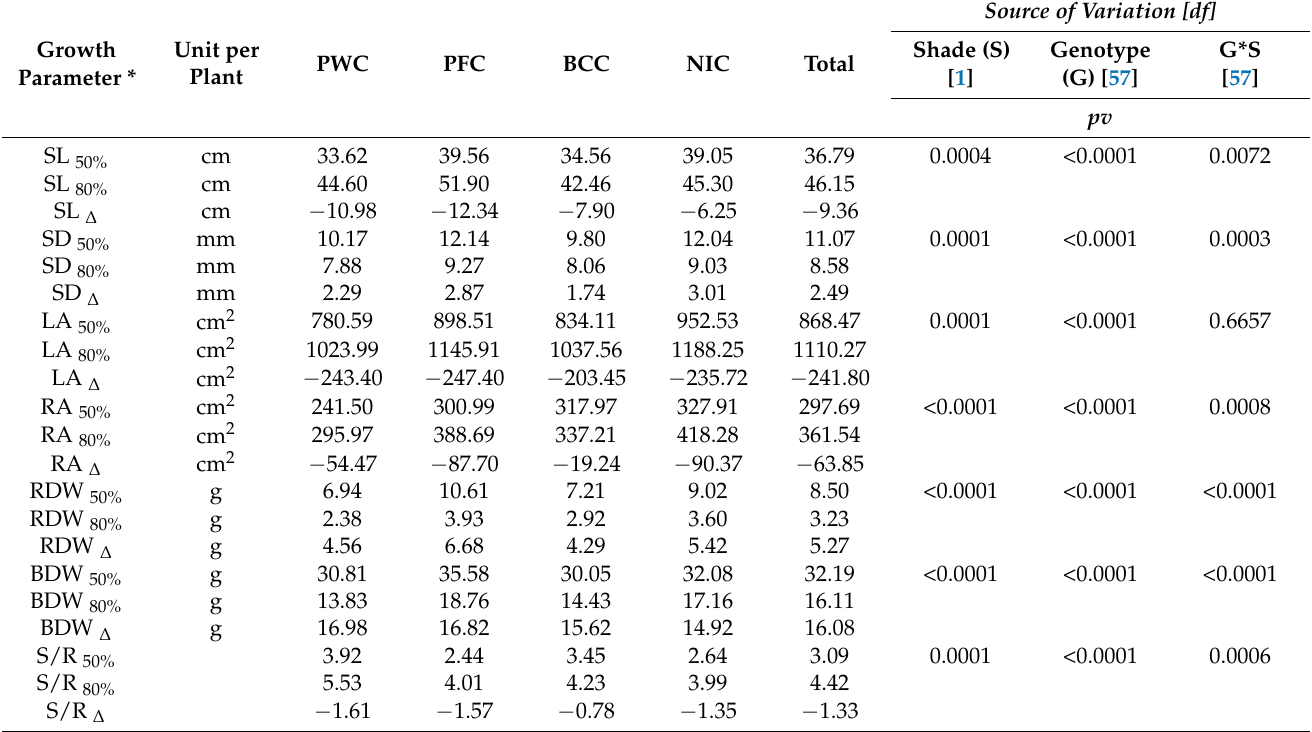
Table 2. Effect of shade on growth parameters in 58 cacao genotypes from different origins subjected to 50% and 80% shade.